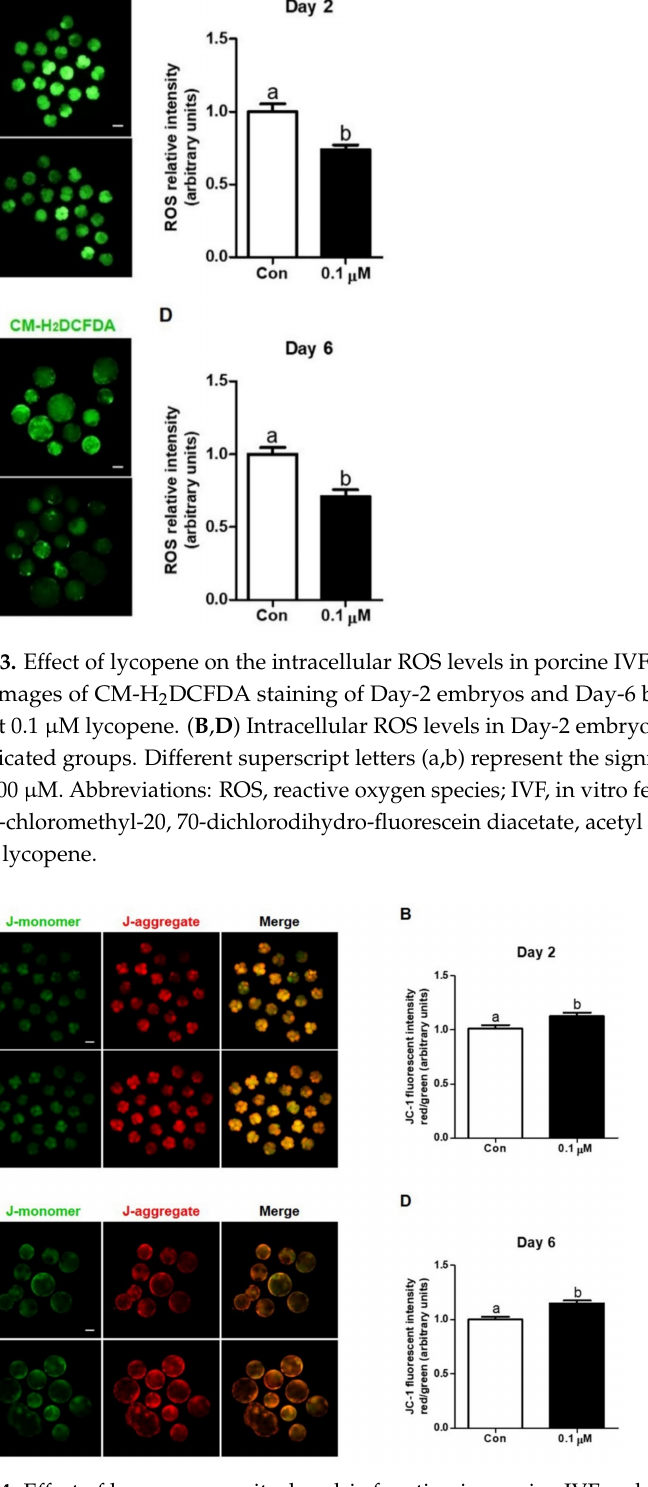
Figure 4. Effect of lycopene on mitochondria function in porcine IVF embryos. ( A , C ) Representative images of JC-1 staining of Day-2 embryos and Day-6 blastocysts treated with or without 0.1 µ M lycopene. ( B , D ) Quantification of the ratio of fluorescence intensity (red/green) in Day-2 embryos and Day-6 blastocysts in the indicated groups. Different superscript letters (a,b) represent the significant difference ( p < 0.05). Bar = 100 µ M. Abbreviations: IVF, in vitro fertilized; Con, control; 0.1 µ M, 0.1 µ M